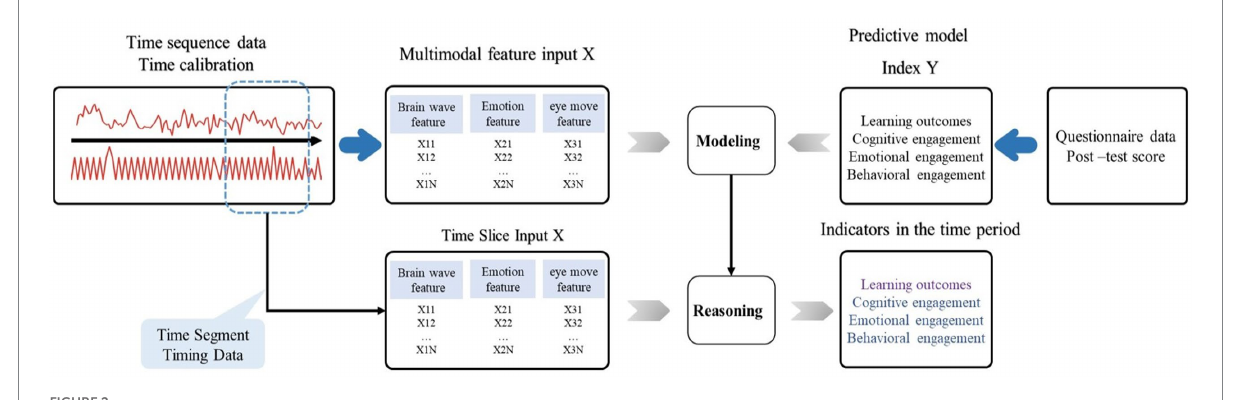
FIGURE 2 Multimodal data streams and predictive modeling approach.